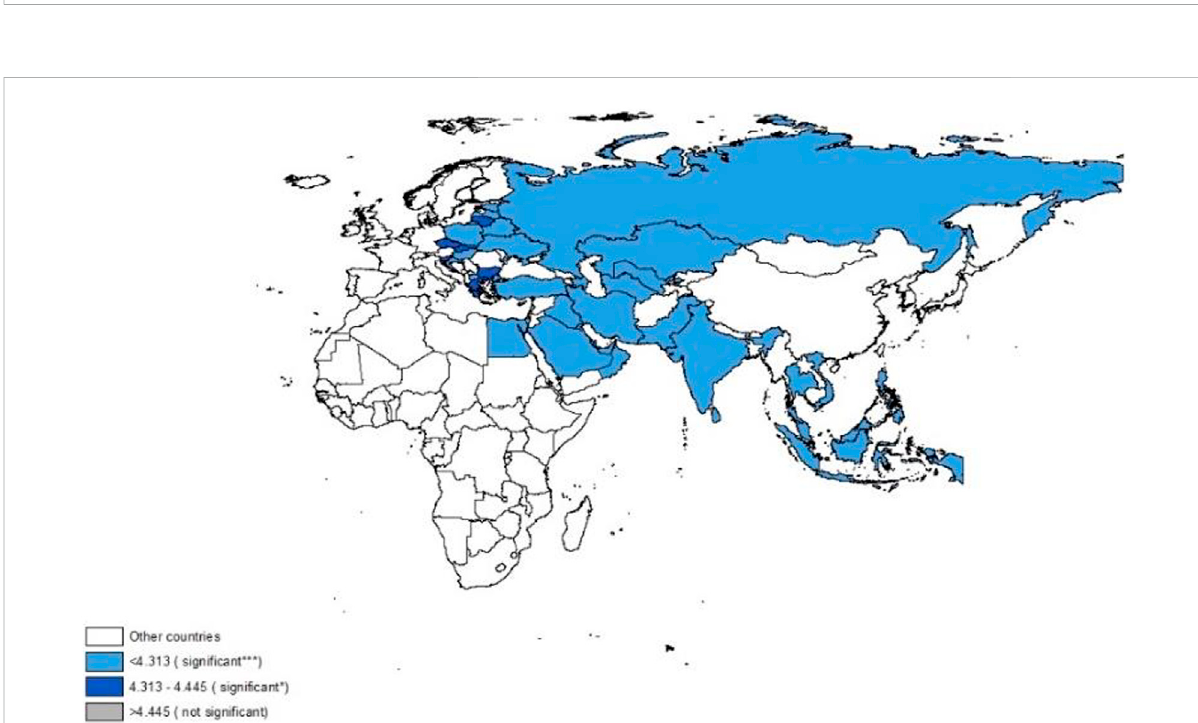
FIGURE 9 Signi fi cance distribution (environmental performance as threshold